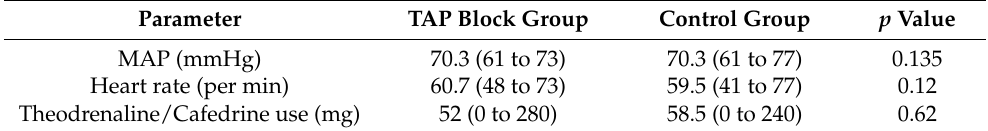
Table 1. Intraoperative circulation